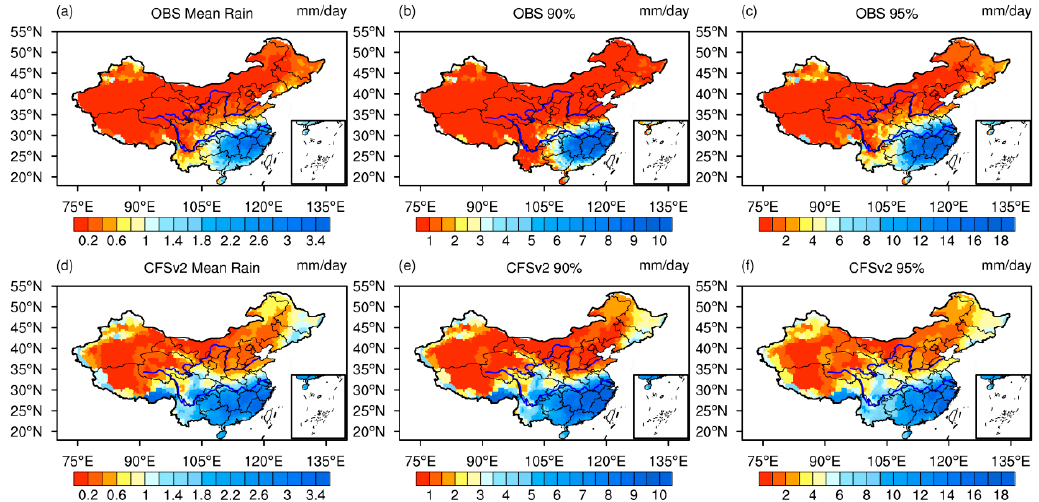
Figure 7. The mean rainfall (left), 90th (middle) and 95th (right) percentile values of rainfall (mm/day) in ( a – c ) observations are compared with those from corresponding ( d – f ) CFSv2 for forecast day 0.